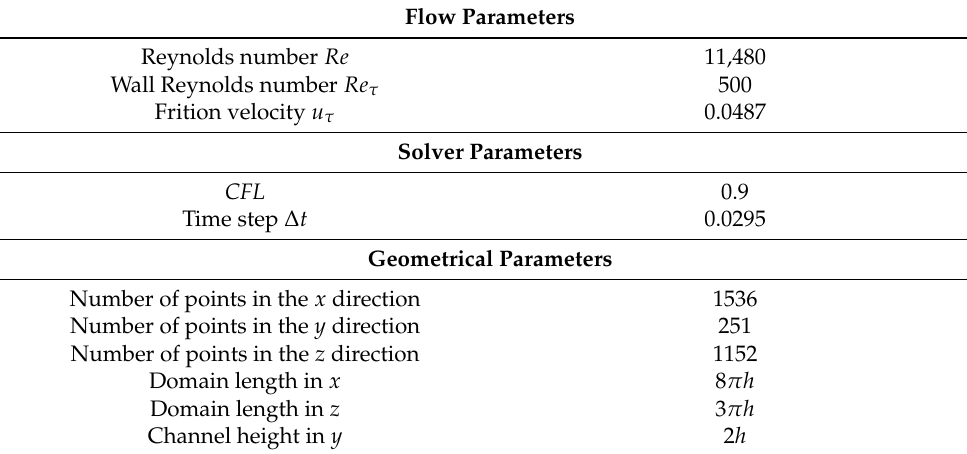
Figure 2. Schematic representation of the turbulent channel used in the simulations, including a description of the reference frame. Table 1. Parameters of the flow, the solver, and the domain of the Direct Numerical Simulation (DNS) simulation, in which this work has been